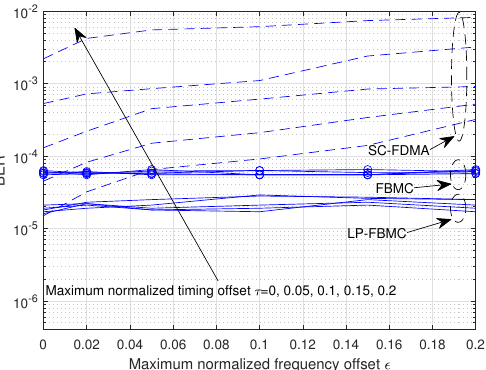
Figure 15. BER of the SC-FDMA, FBMC, and LP-FBMC according to timing/frequency offset, ∆ f = 30 kHz, N = 64, F = 3.5